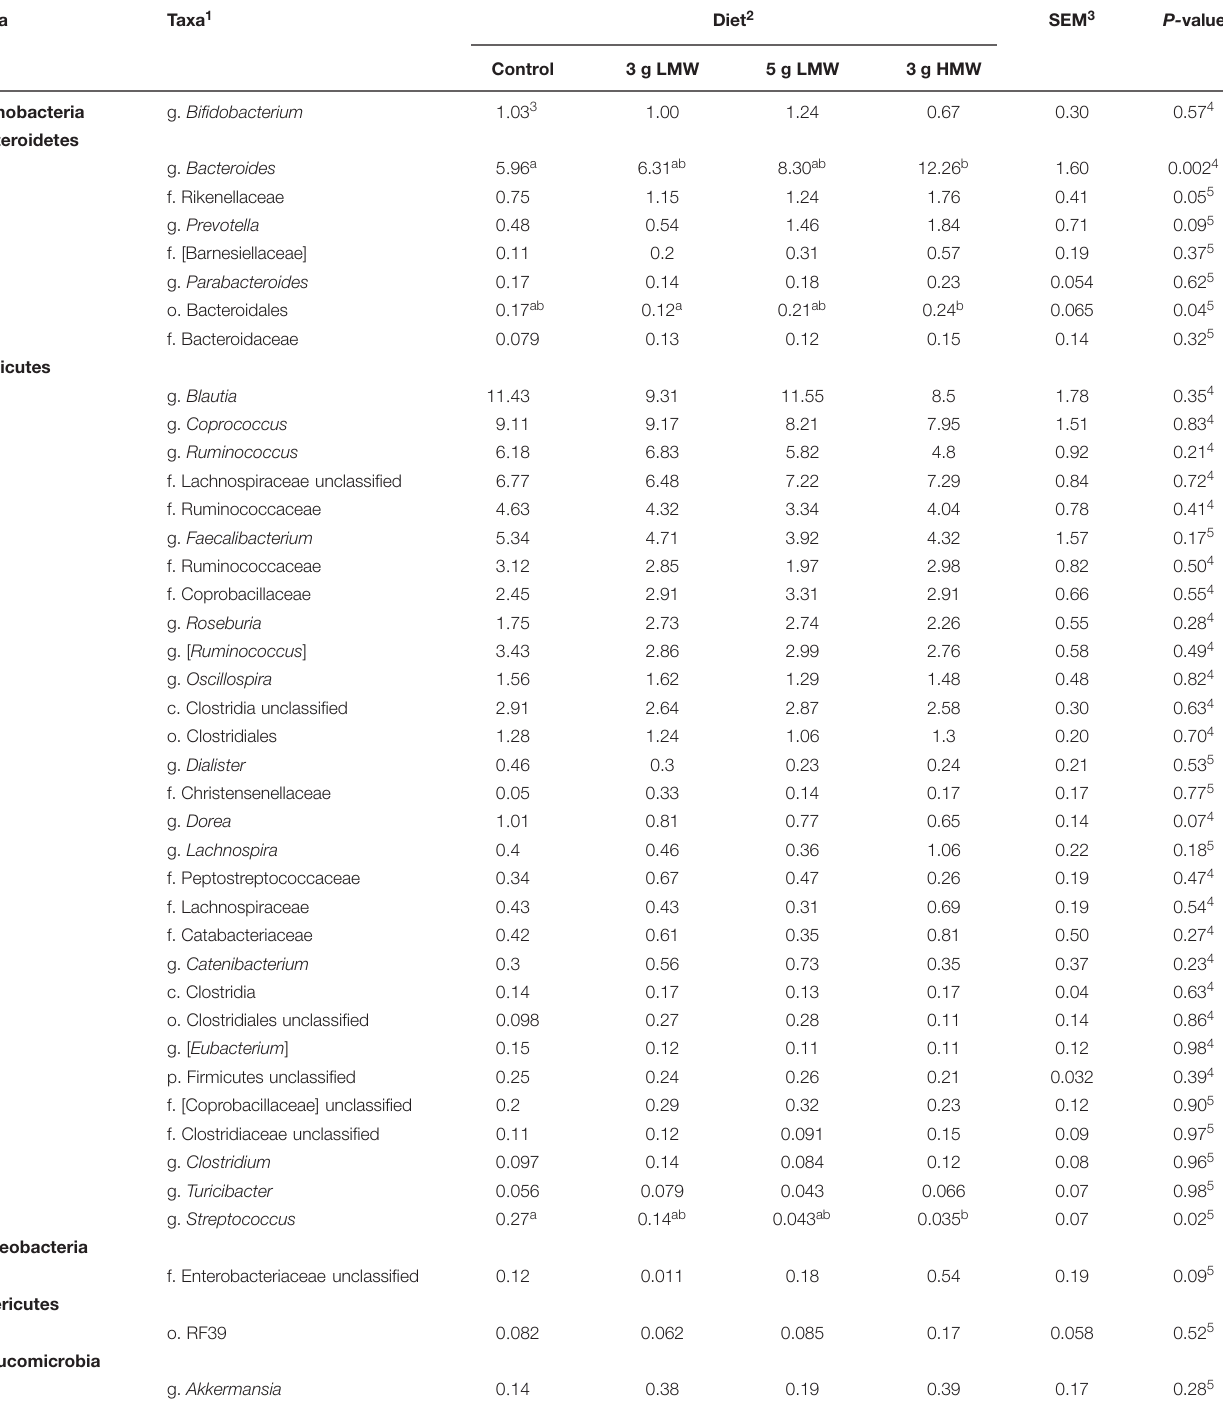
TABLE 3 | Relative abundances of bacterial genera in feces after β -glucan intervention.